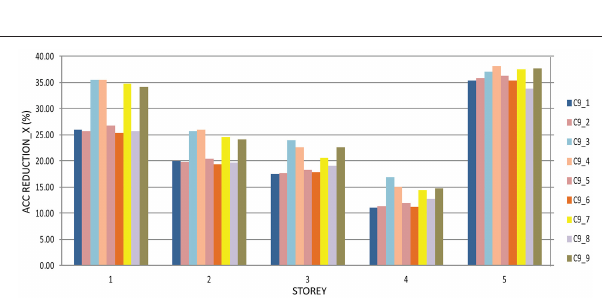
FIGURE 11 | Reduction of the accelerations per stories of the structure with the optimal solutions from the ninth cycle compared with the structure without dampers in X